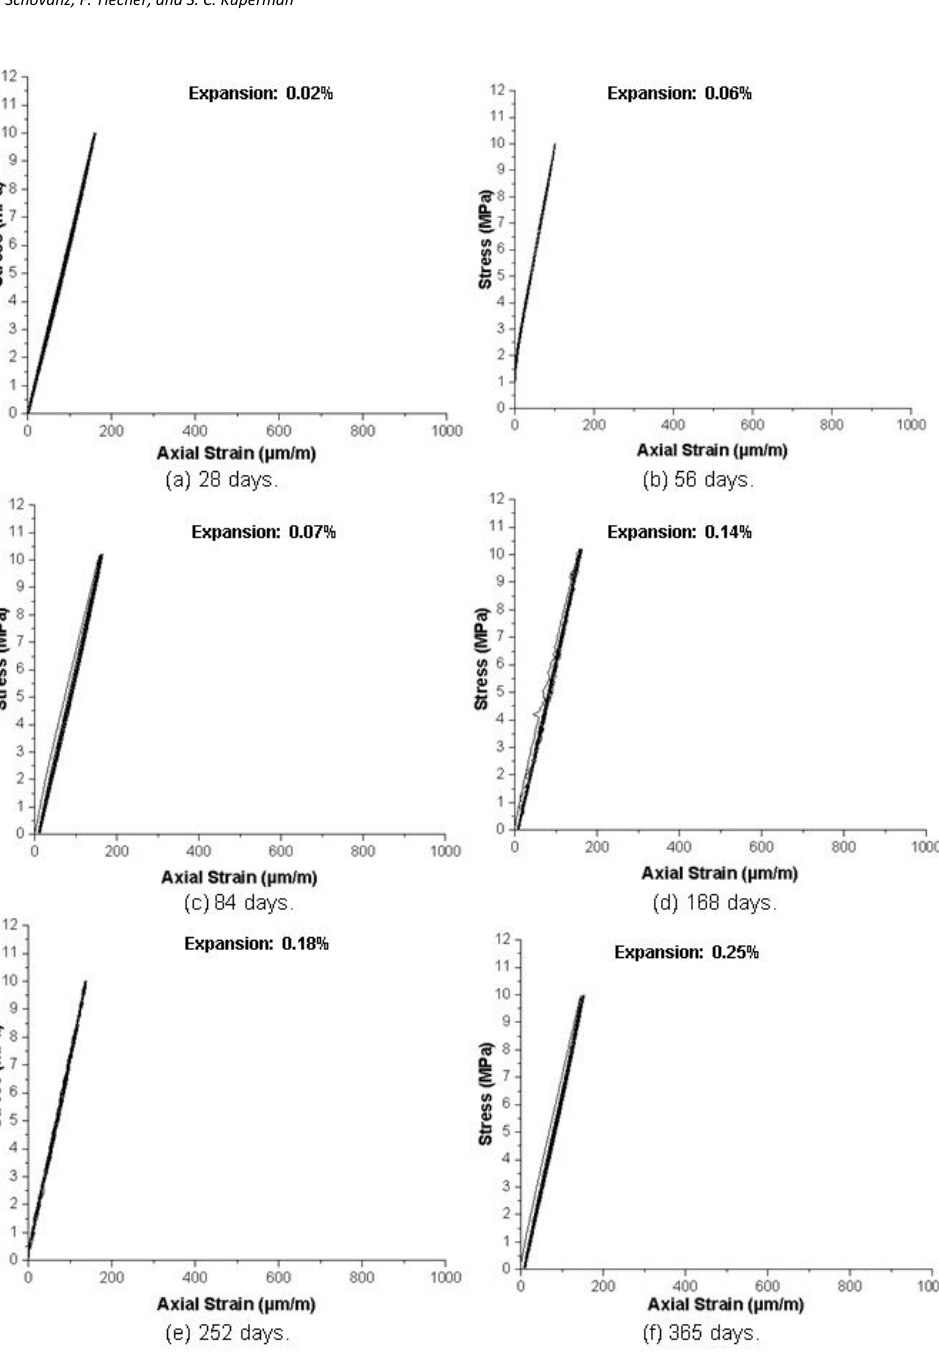
Figure 16. Results of Stiffness Damage Test (SDT) for Type IP